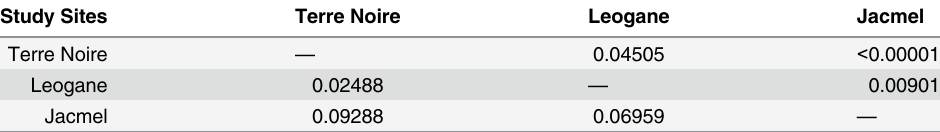
Table 3. Analysis of population structure across three largest sample sites: Terre Noire (Port au Prince), Leogane, and Jacmel. Pairwise F st (bottom half) and p-values (top half) are listed. Study